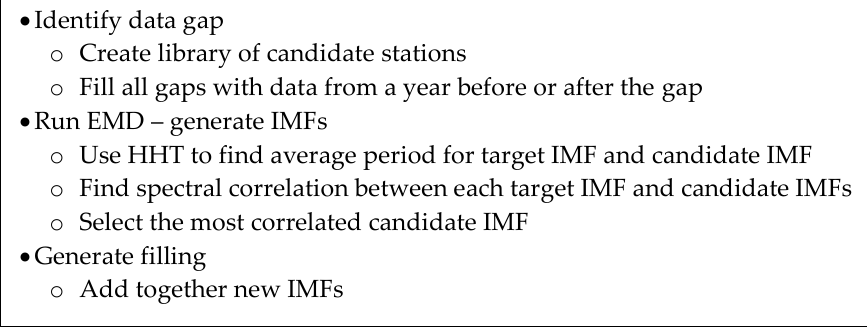
Figure 4. Emperical Mode Decomposition—Spatial Data Imputation (EMD-SDI) process flow chart. This chart presents the algorithm steps for imputation data at a target station given data at a number of candidate stations.